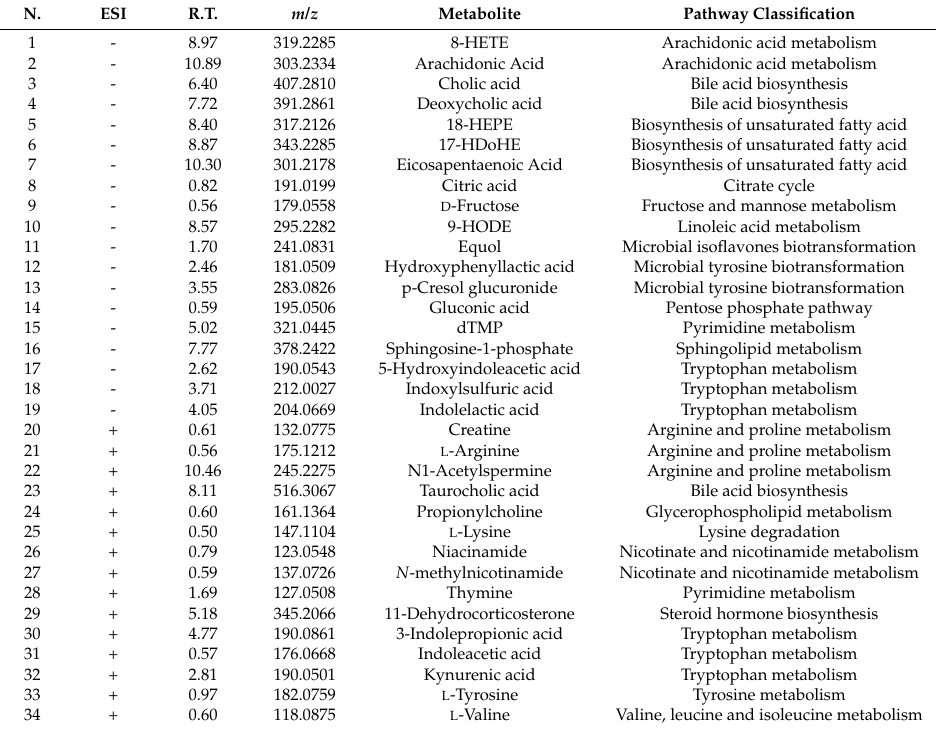
Table 1. Biomarkers identified in the serum of mice induced by DSS.